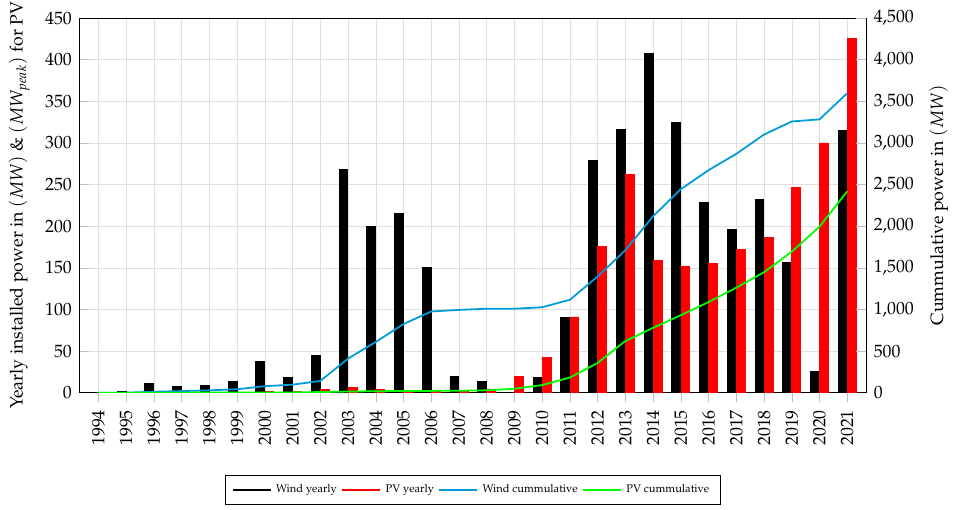
Figure 1. Installation of Wind and PV over the past decades in Austria. Adapted from data of [1] and [2].